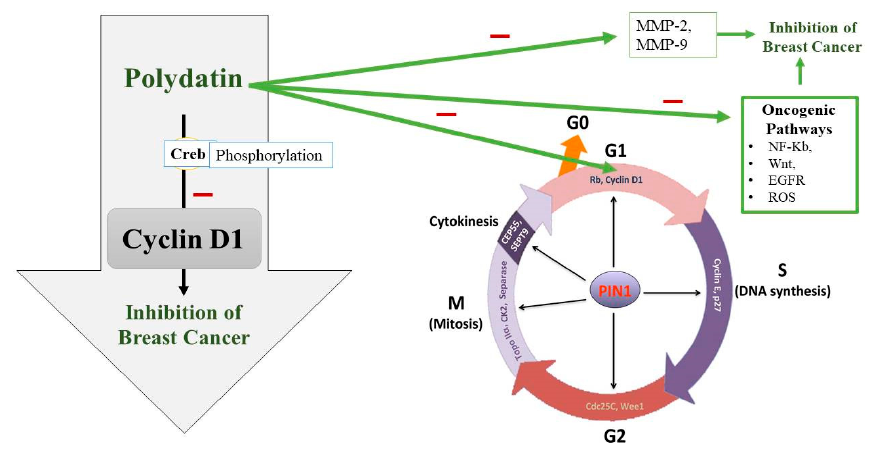
Figure 3. Polydatin (PD) potential to inhibit the G1 phase of the cell cycle along with other oncogenic pathways. PD appears to interfere with Creb phosphorylation, which downregulates Cyclin D1 and thus terminates the cell cycle at G1 phase and in turn inhibits breast cancer growth. PIN1: peptidyl-prolyl cis/trans isomerase, CEP55: Centrosomal protein 55, CK2: casein kinase 2, Rb: the retinoblastoma protein.